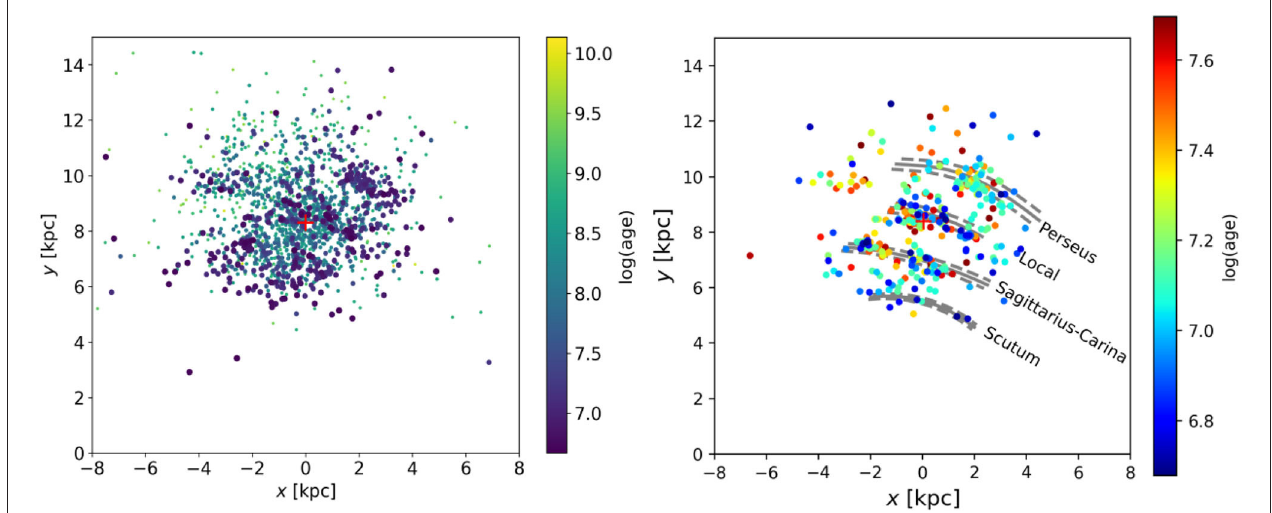
FIGURE 1 | Distribution of the 1,750 open clusters in the Galactic plane. In the right plot are presented the open clusters with ages lower than 50 Myr. In light-gray are the present zero-age arms positions. The Sun (red cross) is at coordinates (0, 8.3)kpc and the Galactic center is at (0,0). The vector angular velocity is perpendicular to the x-y plane pointing in the direction of the